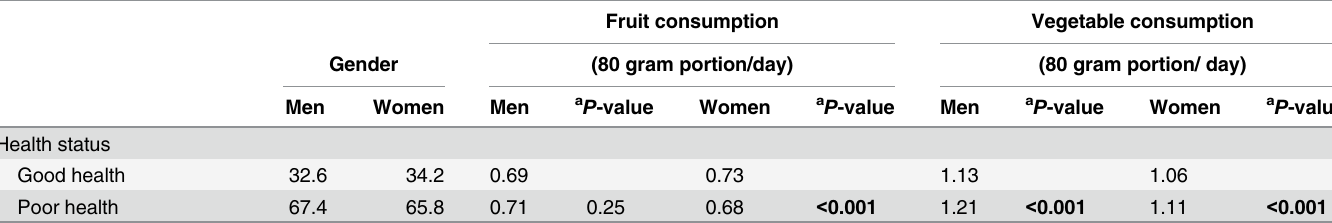
Abbreviations: IPAQ, International Physical Activity Questionnaire; HEPA, health-enhancing physical activity, i.e., vigorous activity at least 3 days a week that corresponds to a minimum of 1500 metabolic equivalent (MET) minutes per week, or activity 7 days of the week that corresponds to at least 3000